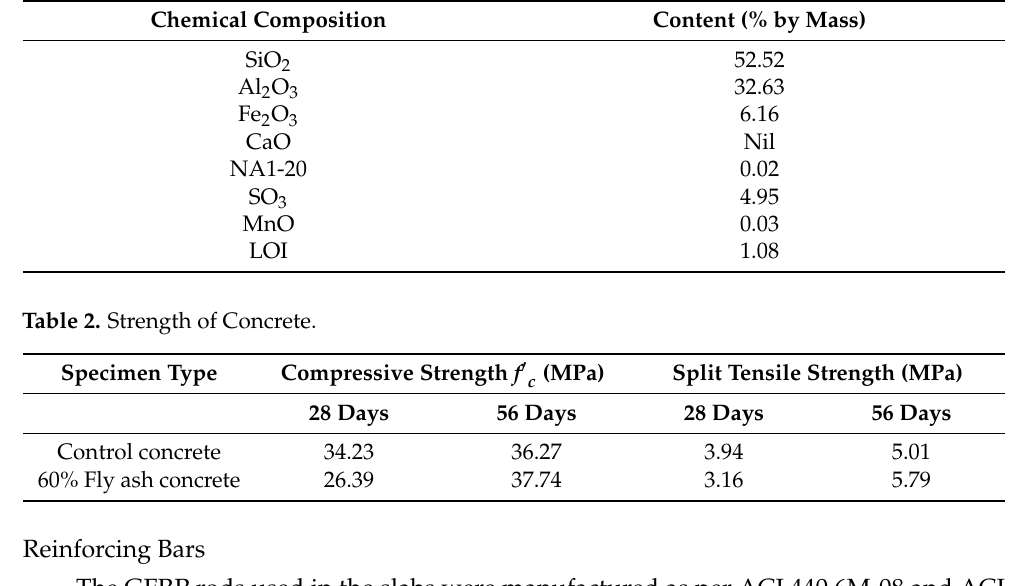
Table 1. Properties of fly ash (class F).